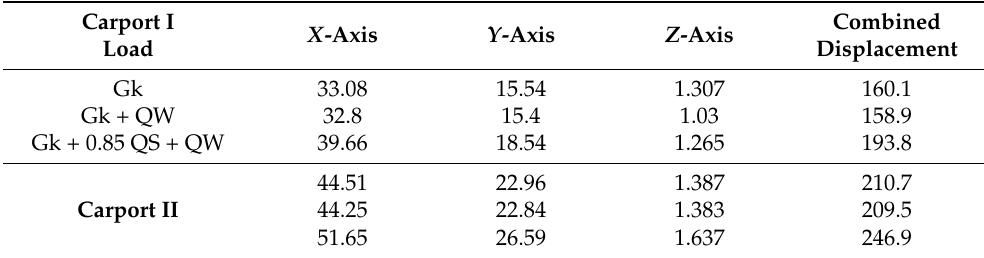
Table 7. Carport I and carport II nonlinear maximum displacement values in each direction (mm).